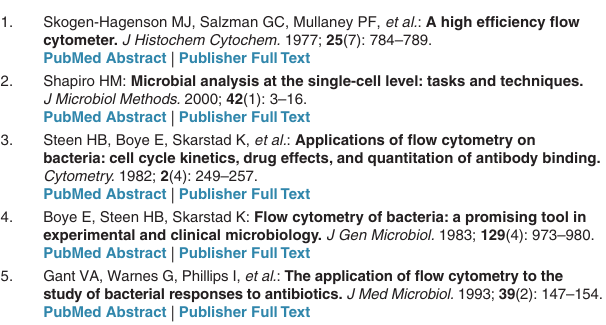
Supplementary Figure 1. Floor plan of both laboratories used in this study drawn to the same relative scale: A. research laboratory and B. clinical laboratory. Numbered locations: 1. preparation bench, 2. acoustic-assisted flow cytometer, 3. additional bench